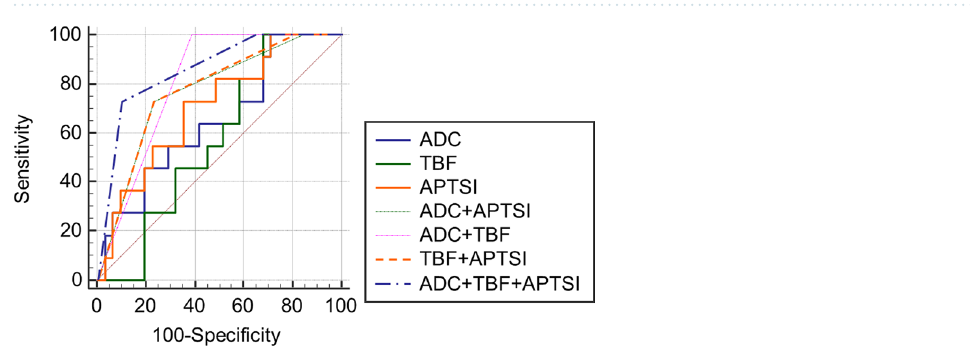
Figure 3. Receiver operating characteristics (ROC) curves for diagnosis of malignant salivary gland tumors. The area under the ROC curve of the combination of the three parameters (ADC, TBF, and APTSI) was significantly greater than that of each parameter alone (p = 0.044, 0.006, 0.010,